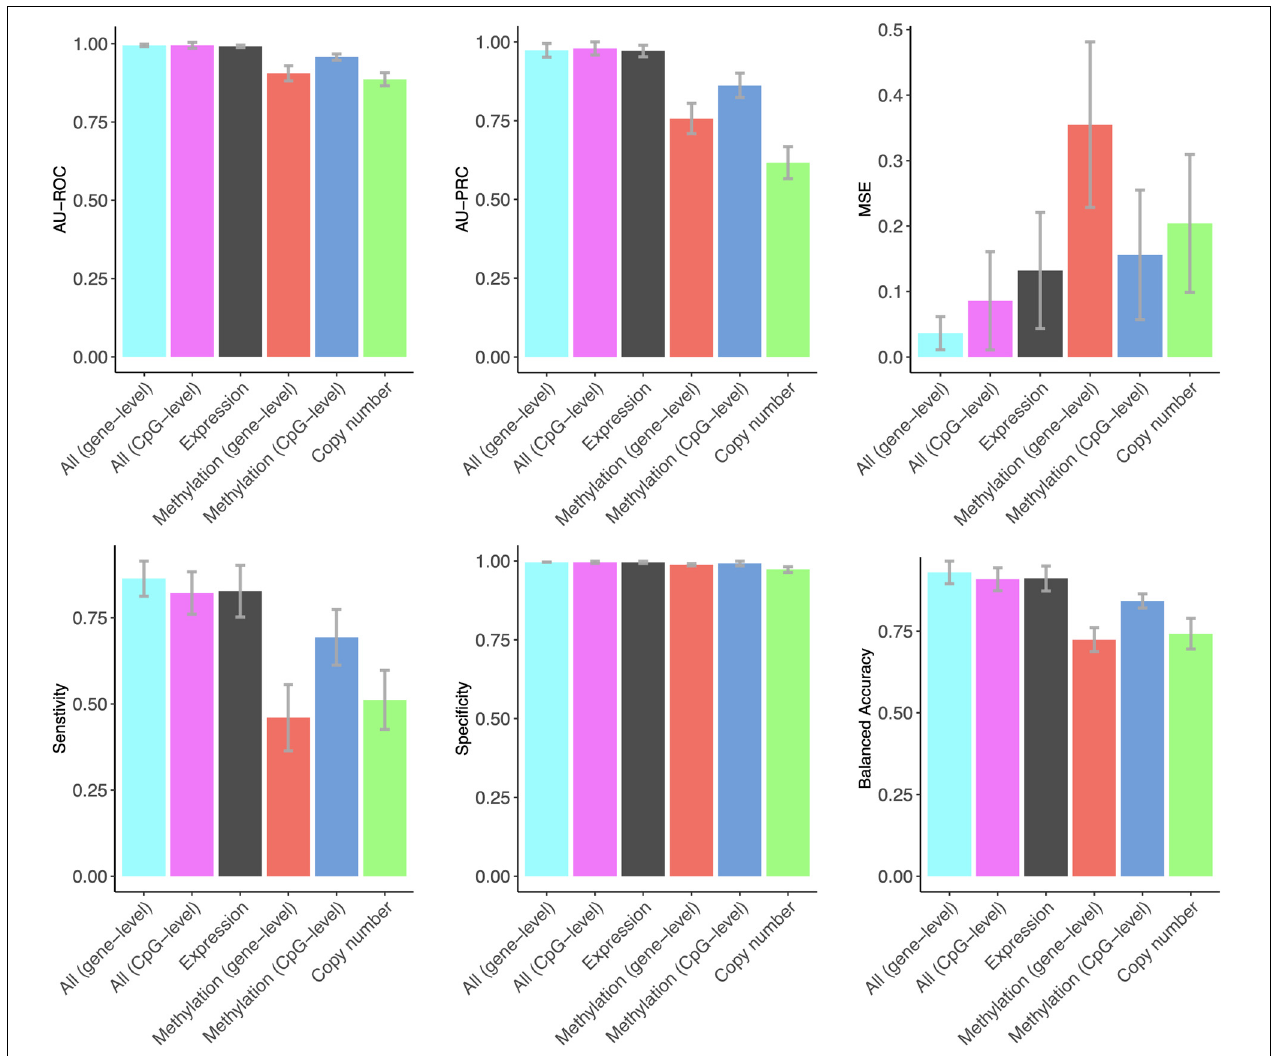
FIGURE 1 | The predictive contribution of omics profiles and their combinations to DCIS vs. IBC classification. The bars show the average accuracy over 10 CV folds, and the error bars indicate the standard error of the mean (SEM). These data correspond to those shown in Supplementary Table 1 . ROC and PRCs of CV folds using various omics data combinations are shown in Supplementary Figure 3